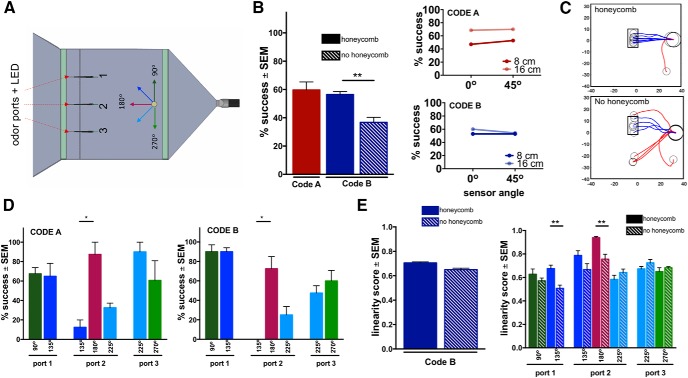
Arduino-based robot navigation varies based on start position and odor environment complexity. A, Robot odor navigation flow chamber, modifications to the SOL. Solid arrows represent five starting angles. Odor ports were coupled to LED lights detected by sensors on the robot (indicated by dotted red arrows). B, Performance (average % successful trials over 8 and 16 cm and 0° and 45° gas sensor distance and angles, respectively) across codes (left). Performance based on gas sensor distance and angle for the honeycomb condition (right). C, Example trajectories from 180° (magenta) starting position in A for honeycomb and no honeycomb condition. D, Performance (average % successful trials over 8 and 16 cm and 0° and 45° gas sensor distance and angles, respectively) with the honeycomb based on starting angle and rewarded port for Code A (left) and Code B (right). Bars are color coded and labeled according to the starting angles in A. E, Robot overall linearity score with honeycomb and without honeycomb using Code B. Plot shows data combined over sensor angle and sensor distance for each odor environment condition (left). Linearity score across starting angles and target ports with and without the honeycomb. All plots show mean ± SEM, n = 4 sessions. See also Extended Data Figure 4-1. *p < 0.05, **p < 0.01.